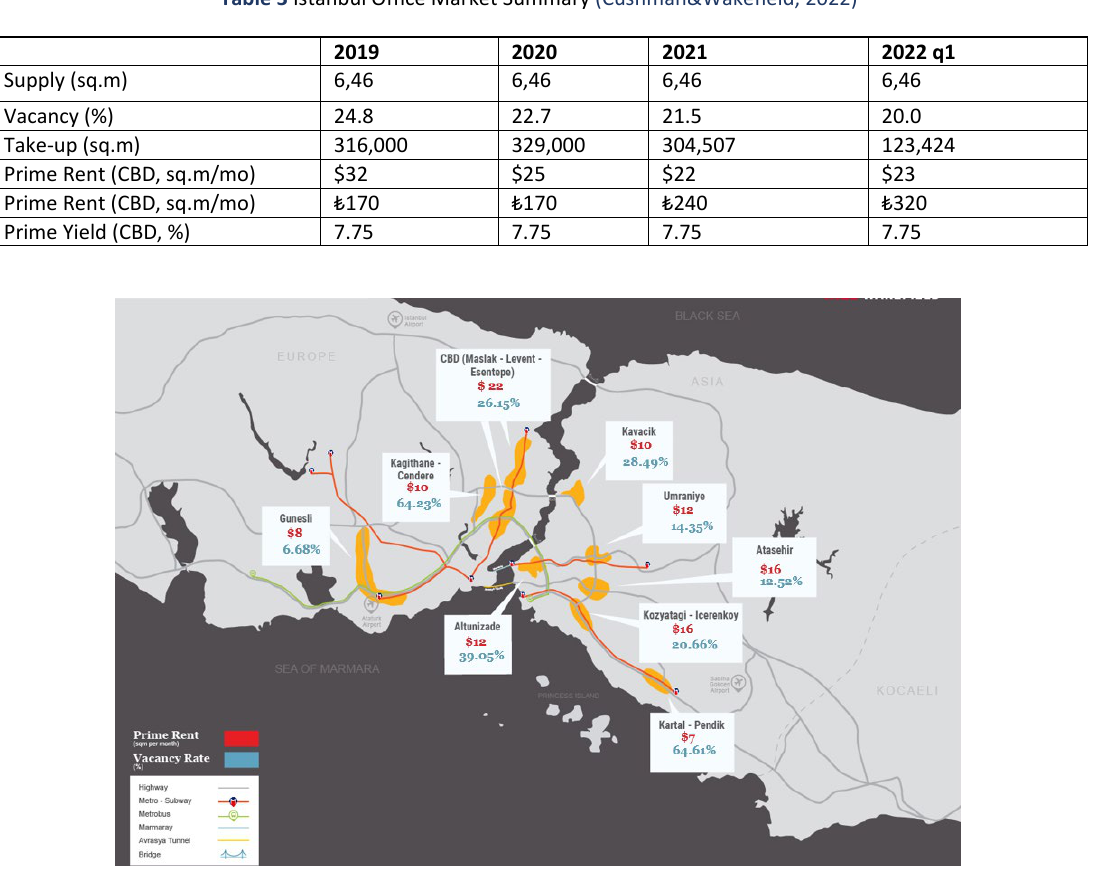
Figure 10 Istanbul Prime Office Areas Map- Rent and Vacancy Rates (Cushman&Wakefield